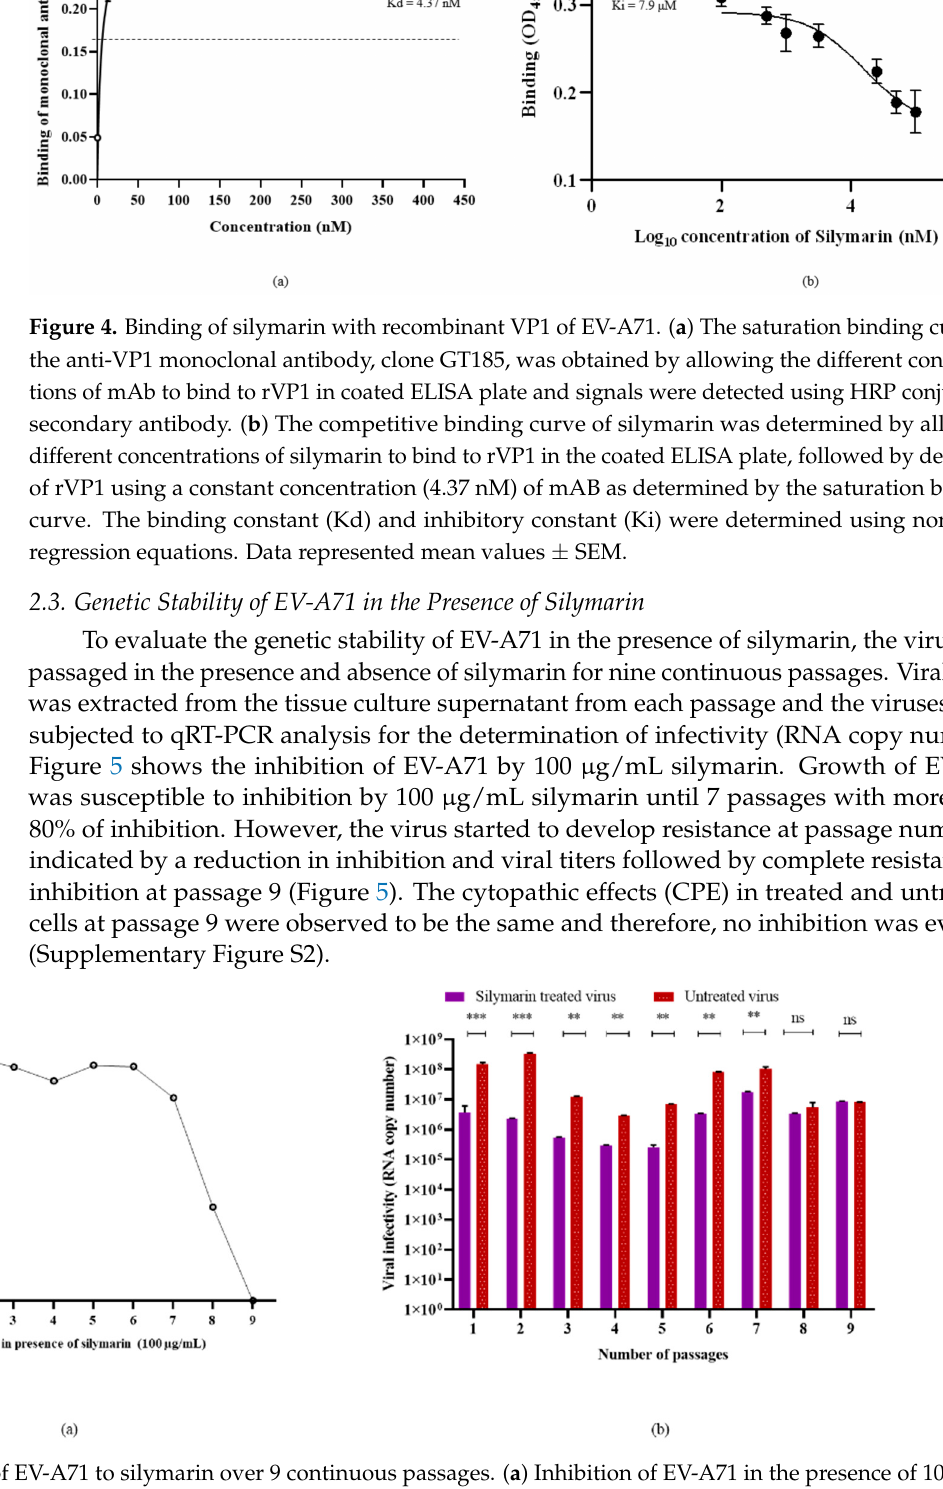
Figure 5. Susceptibility of EV-A71 to silymarin over 9 continuous passages. ( a ) Inhibition of EV-A71 in the presence of 100 µ g/mL silymarin over nine passages. ( b ) Virus titers of EV-A71 passaged in the presence of 100 µ g/mL silymarin (S1–S9) and titers of EV-A71 passaged without silymarin in media (V1–V9) in media. ** p < 0.01, *** p < 0.001, indicate a significant difference analyzed by t -test. ns = non-significant.